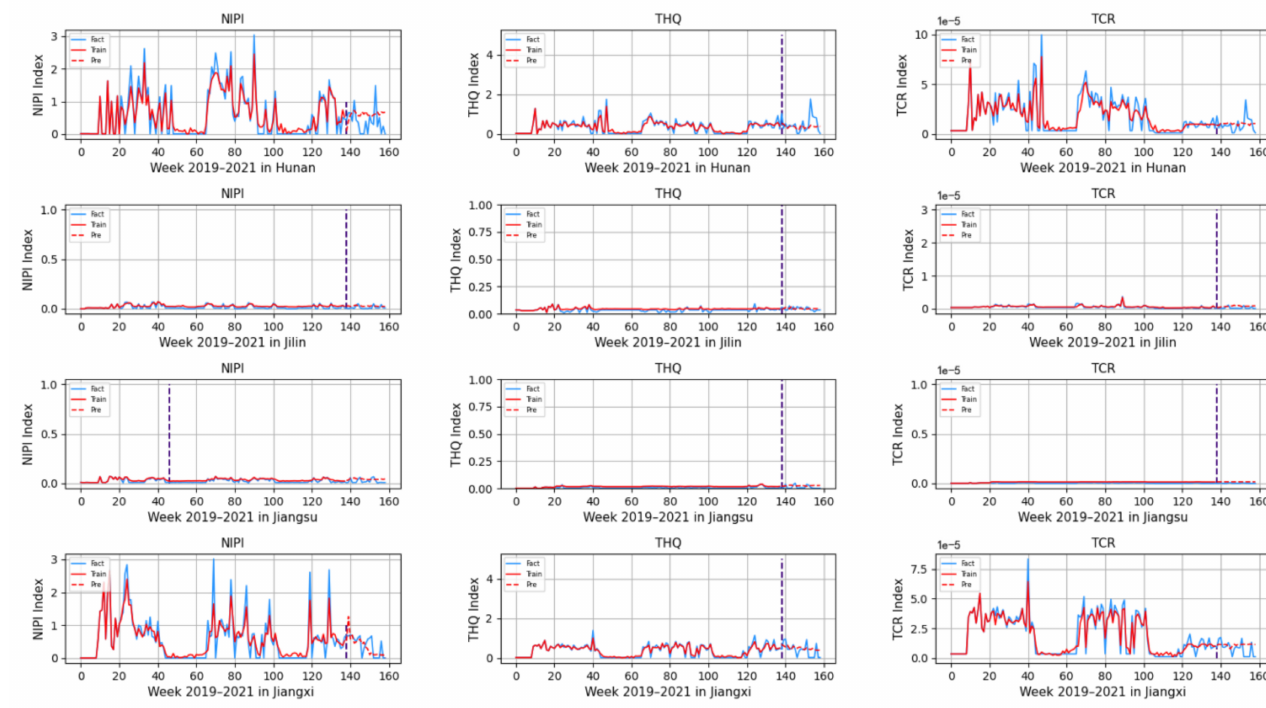
Figure 12. Predicted NIPI, THQ, and TCR indicators for Hebei, Henan, Heilongjiang, and Hubei.